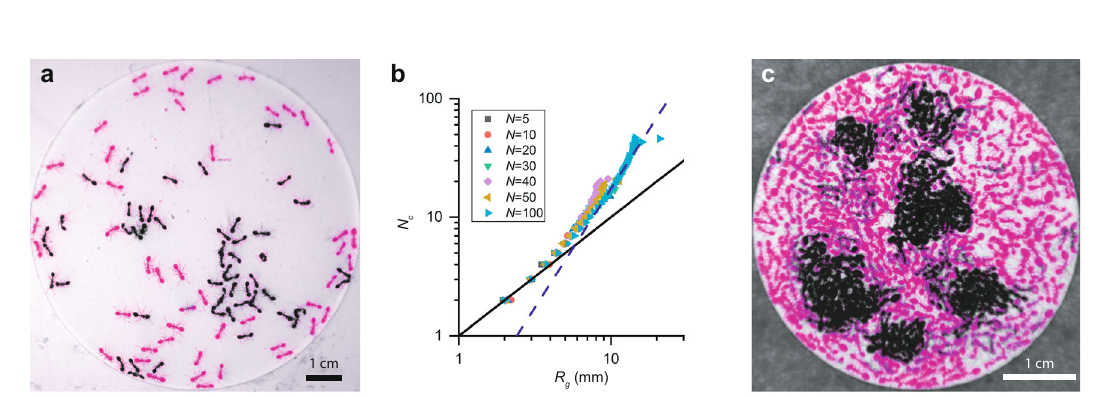
image ofabout 625antsinacellwith D =4.50cm. Ants thatremainstationaryover thirtysecondsareshowninblackandantsthatmoveoverthirtysecondsareshown in